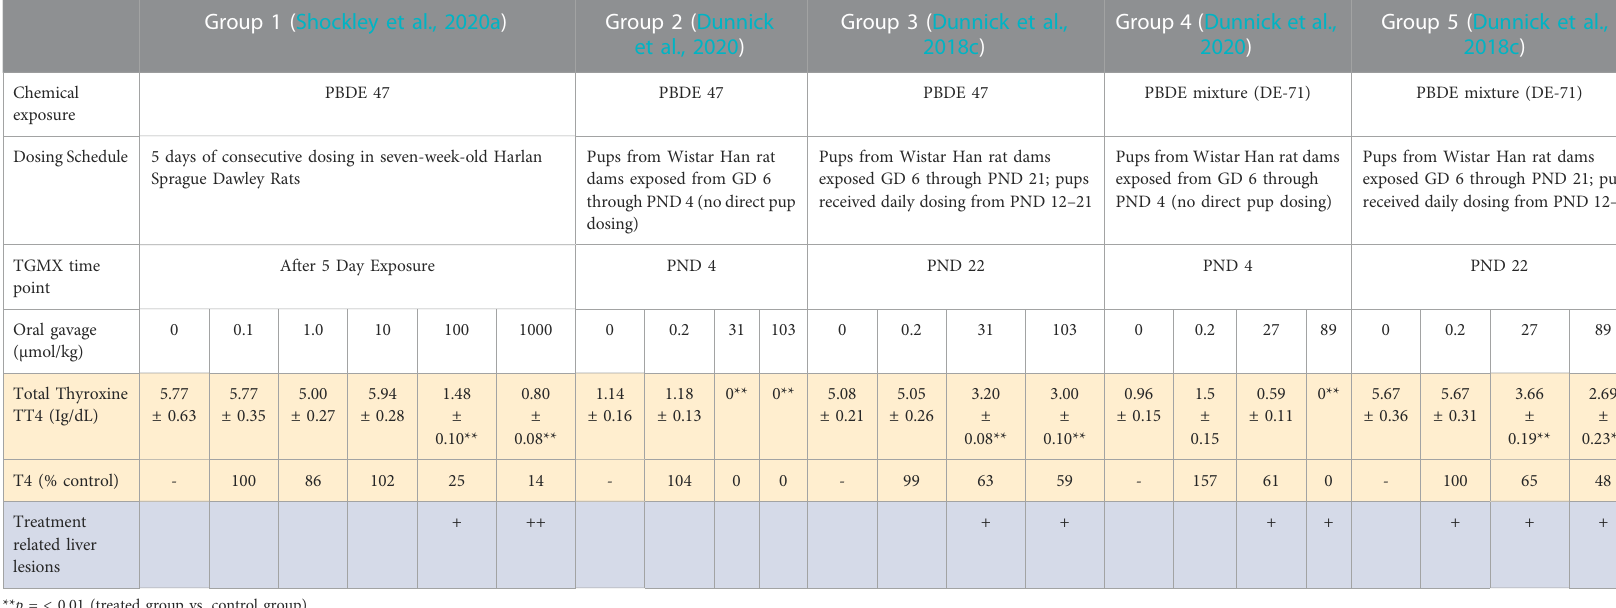
TABLE 1 Summary of thyroid hormone levels and liver pathology fi ndings after exposure to PBDE 47 and/or PBDE mixture (DE-71) at different life cycle